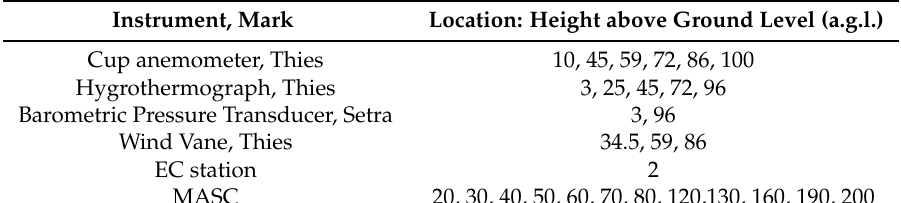
Table 1. Overview of instruments.